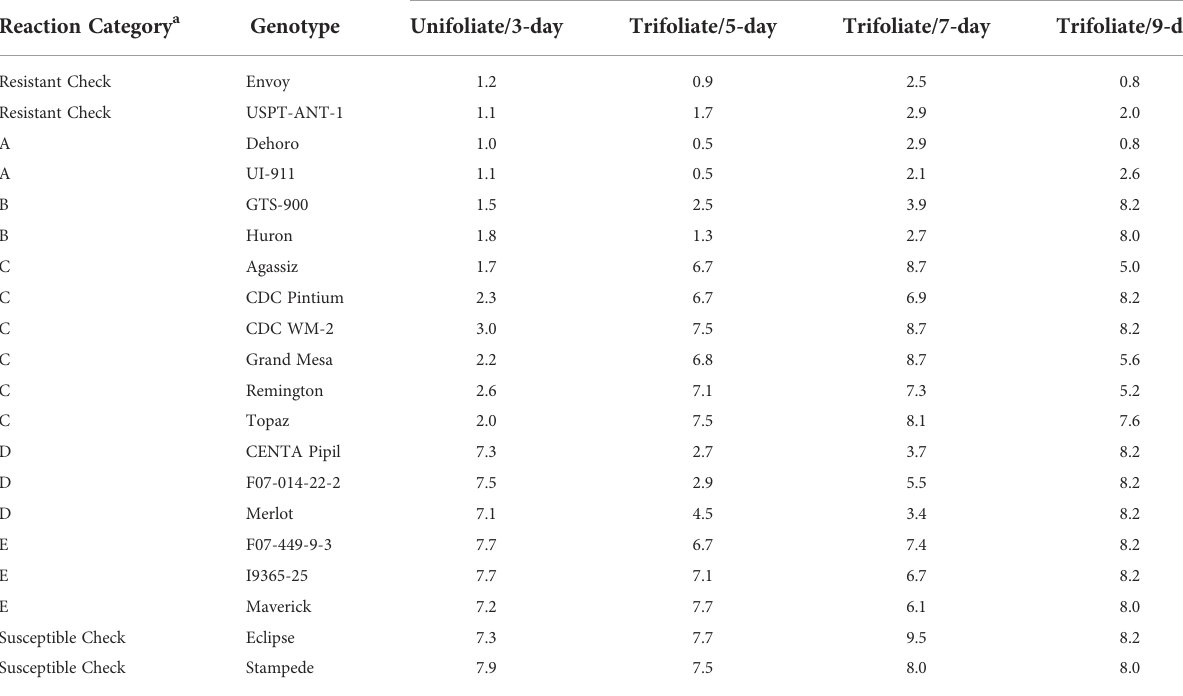
TABLE 2 The disease reaction of 16 genotypes with observed ARR to race 73 reevaluated under controlled environmental conditions and various growth